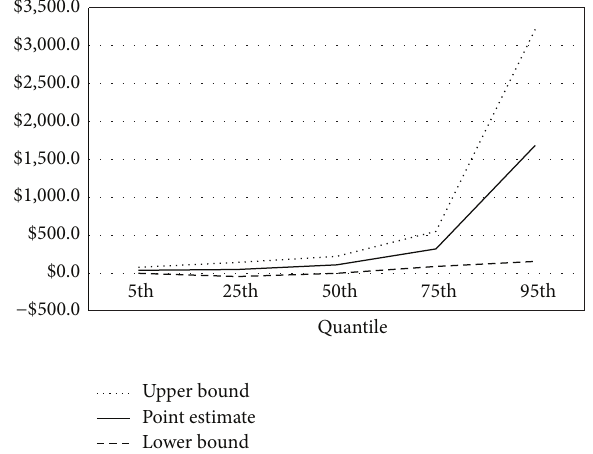
Figure 1: Weighted relationship between residence and nonzero expenditure of outpatient care, adjusted by 10 covariates.